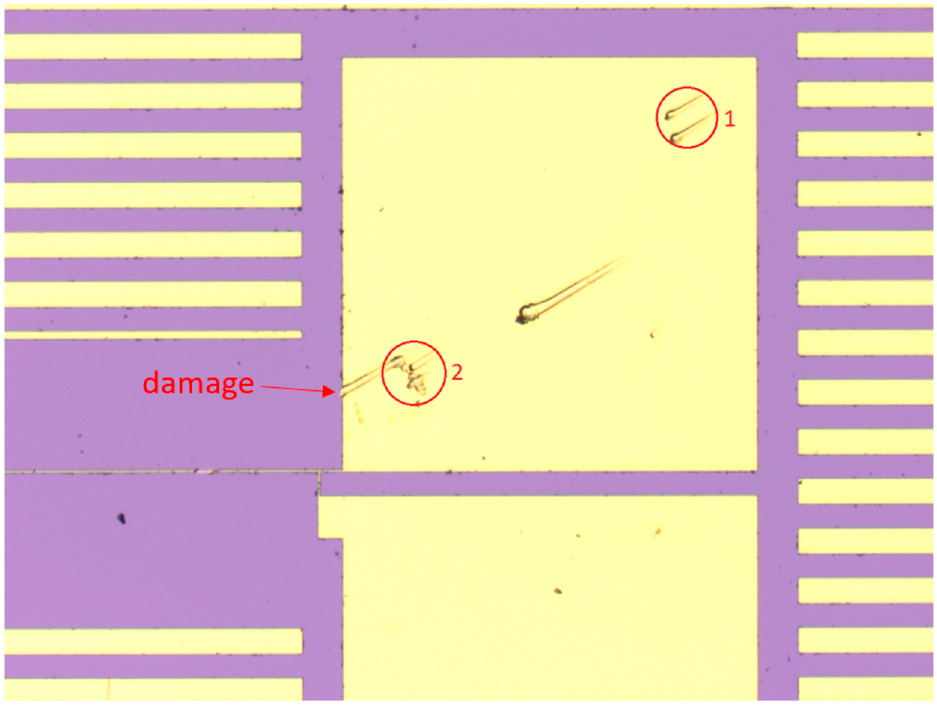
Figure 7. Contact pad of 3-Omega structure with two different contact positions. The positions were mirrored on the second contact pad. To the left of the second contact point, slight damage was induced to the contact pad after all other measurements were carried out.